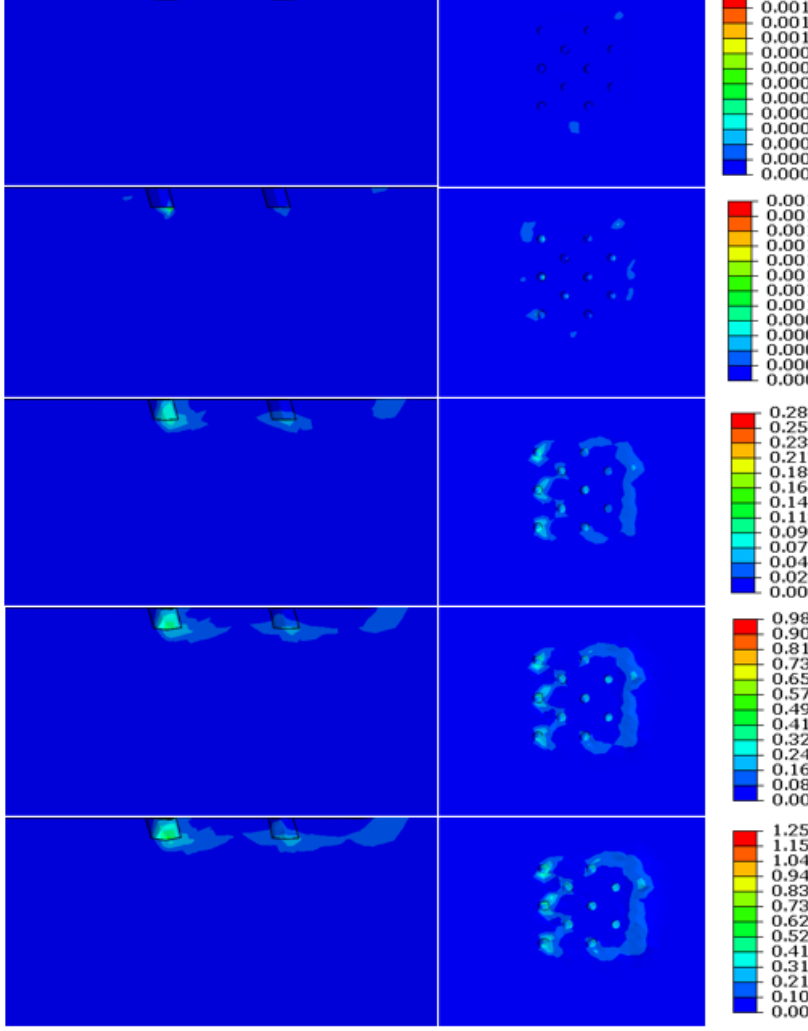
Figure 14. The plastic deformation process of the soil sections at rear of gravity achor.